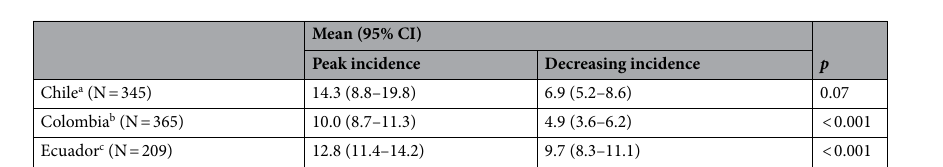
Figure 1. Confirmed cases rate in the four participating countries. Confirmed case rate per 1 million population from March 1 to September 30, 2020. The trend line is observed, and each point of dispersion corresponds to the daily record reported by each country. It can be seen how Argentina is climbing the curve of cases without reaching a peak. Chile had it between the dates of May 20 and June 30. Colombia from July 19 and currently, the cases seem to be decreasing and in Ecuador, which had its peak of cases in the month of April– May.